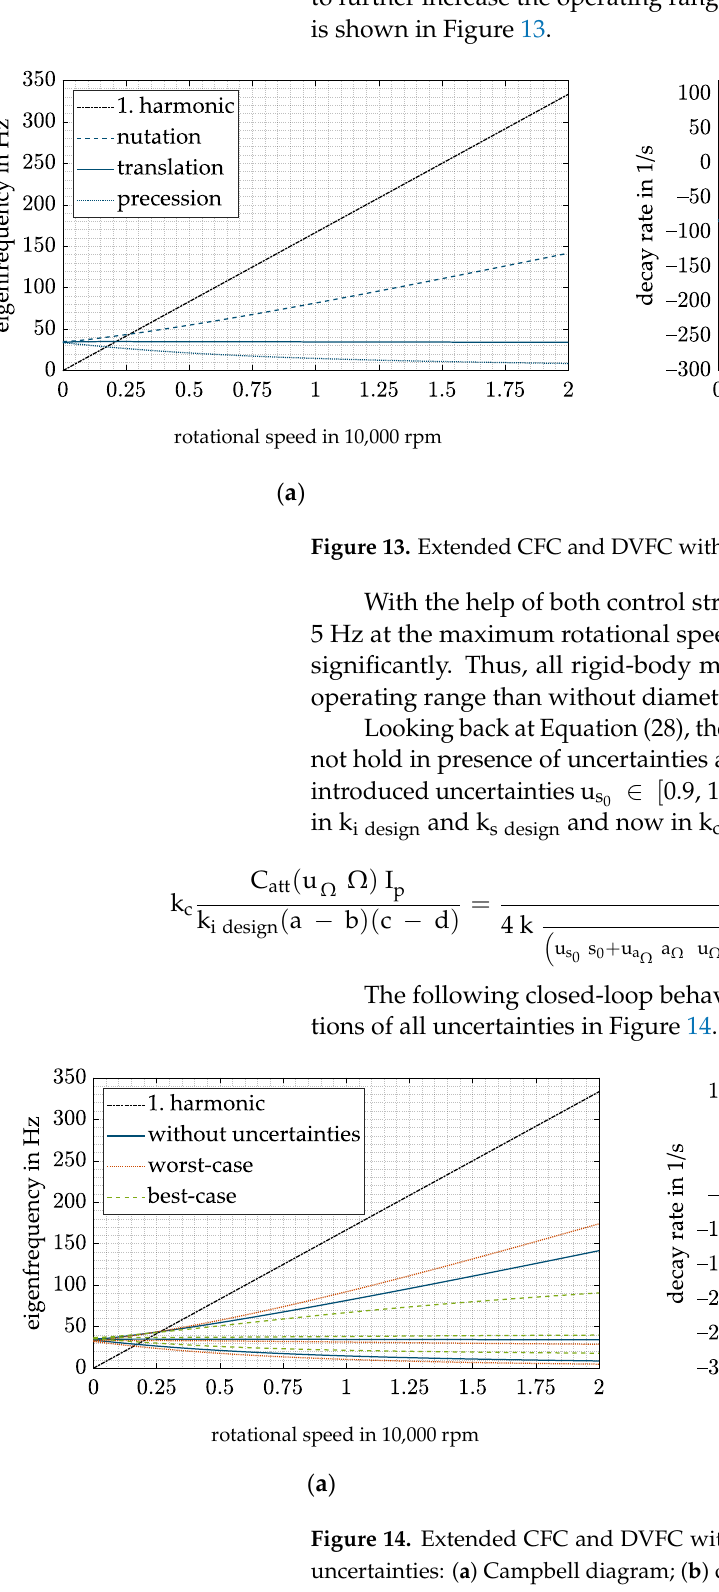
Figure 12. DVFC and worst-case design for best-case combination of all uncertainties: ( a ) Campbell diagram; ( b ) decay rate.